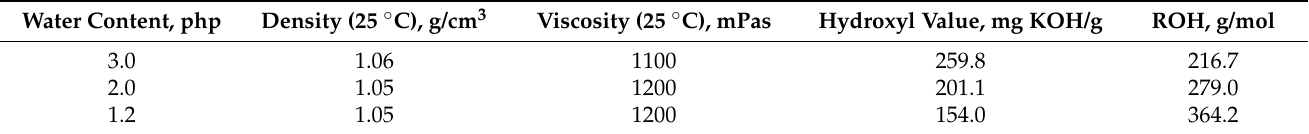
Table 1. Characteristics of polyol